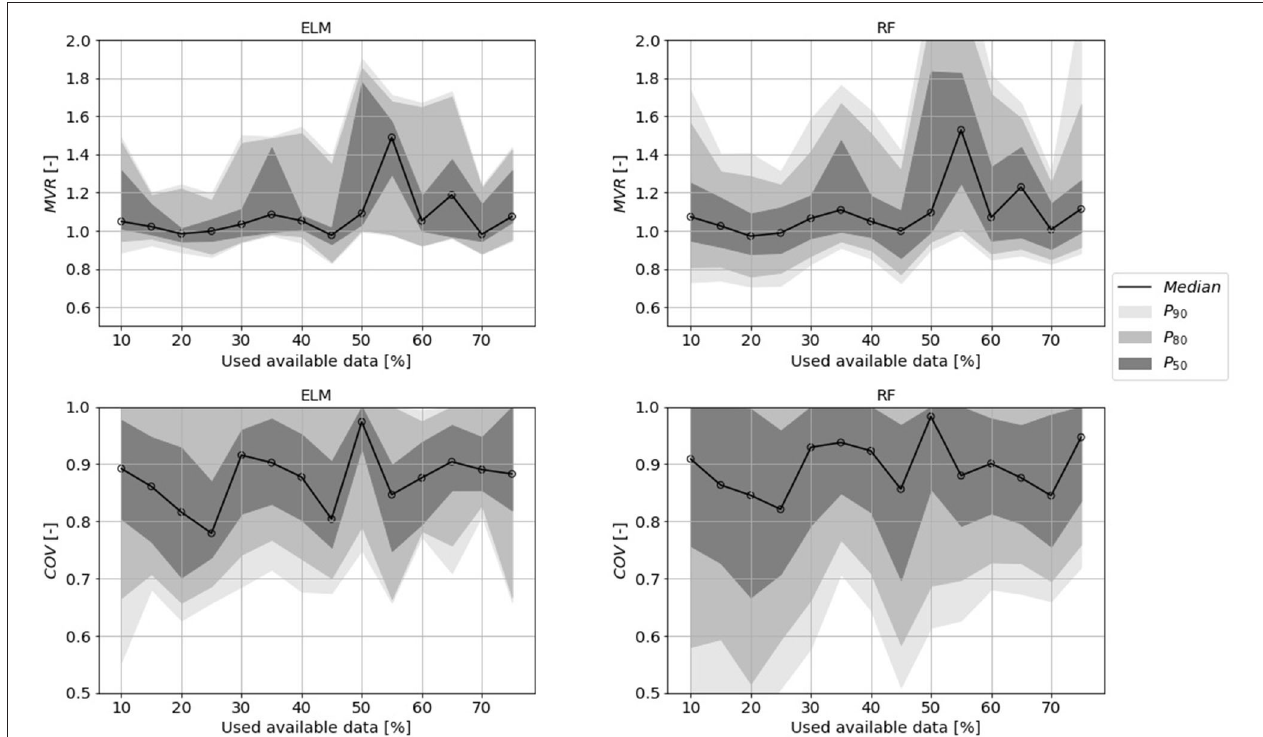
FIGURE 8 | Dependence of mean volume reproduction (MVR)/temporal coverage (COV) and size of the training data set of a random forest (RF) and an extreme learning machine (ELM). Uncertainty belts drawn in gray scales for different probabilities (50, 80, 90%). The amount of training data has been raised incrementally to train the algorithms and were validated in each step with the same data set, containing 25% of the available